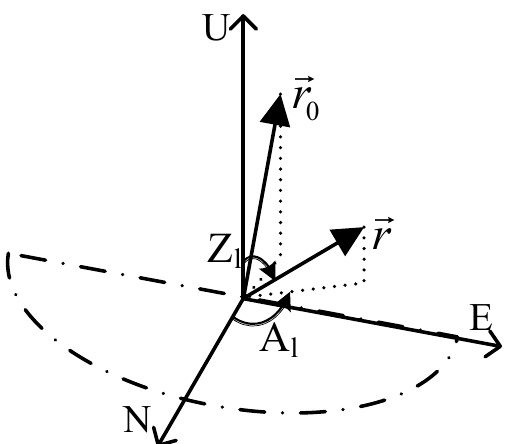
Figure 2. The instantaneous solar vector and the best pointing vector in the local spherical coordinate system.